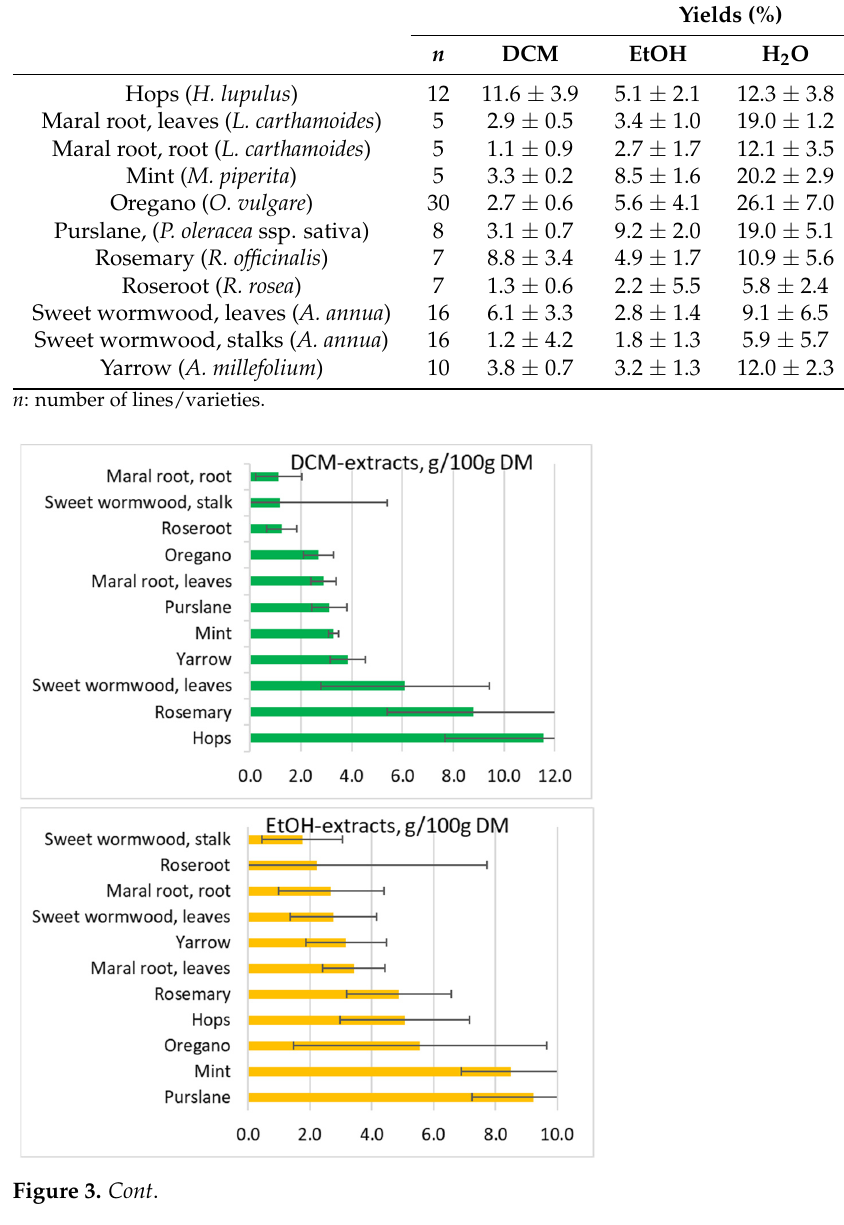
Figure 3. Eleven herbal extracts arranged by increasing yields (g 100 g − 1 DM ± SD) for three sequen- tial extraction steps: DCM ( green ) followed by EtOH ( yellow ) and H 2 O ( blue ). Total extraction yield of all three samples (DCM + EtOH + H 2 O) ( red ).